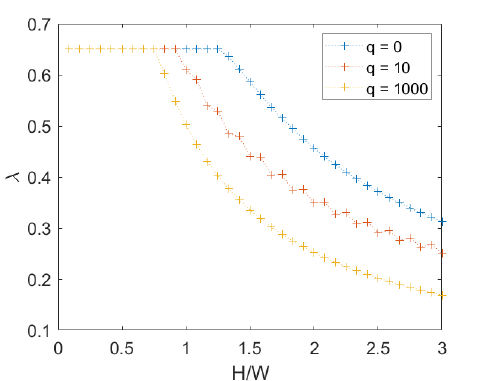
Figure 5. Periodic masonry: failure multipliers for different values of vertical load q .